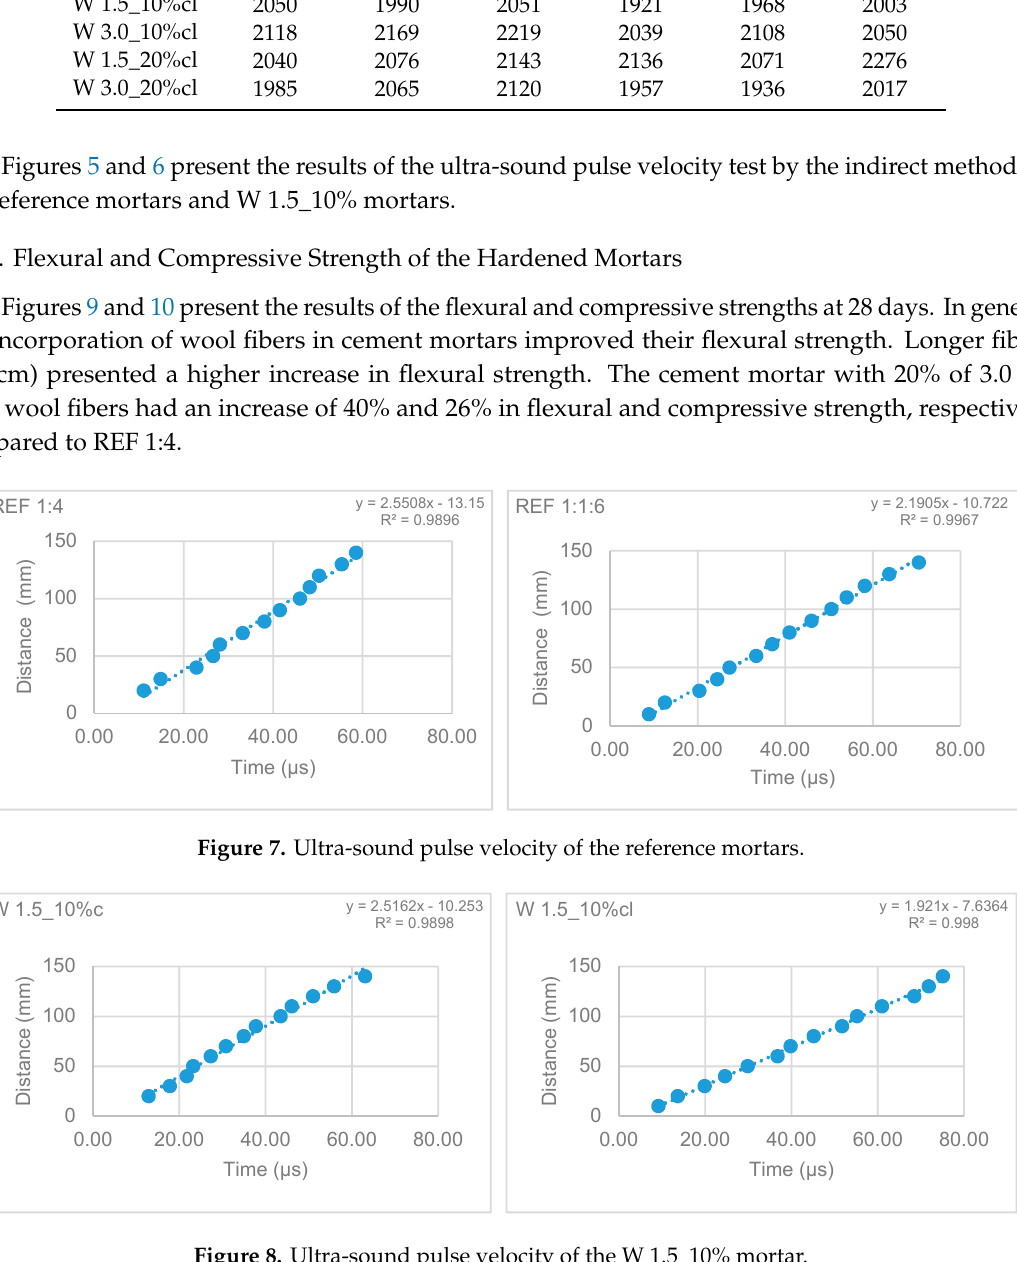
Figure 9. Flexural strength of the mortars at 28 days. Figure 10. Compressive strength of the mortars at 28 days. ( a ) ( b ) Figure 11. Flexural strength test ( a ); compressive strength test ( b ).